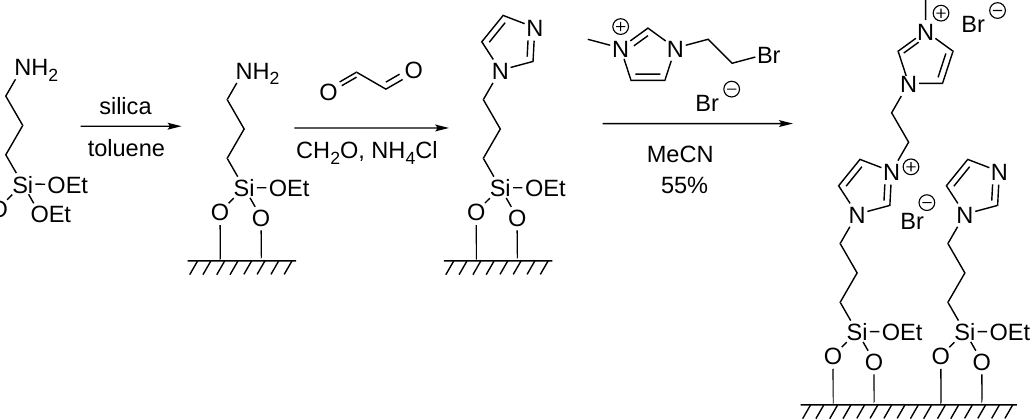
Figure 22. Preparation of the SLIP phase used for immobilizing the Pd